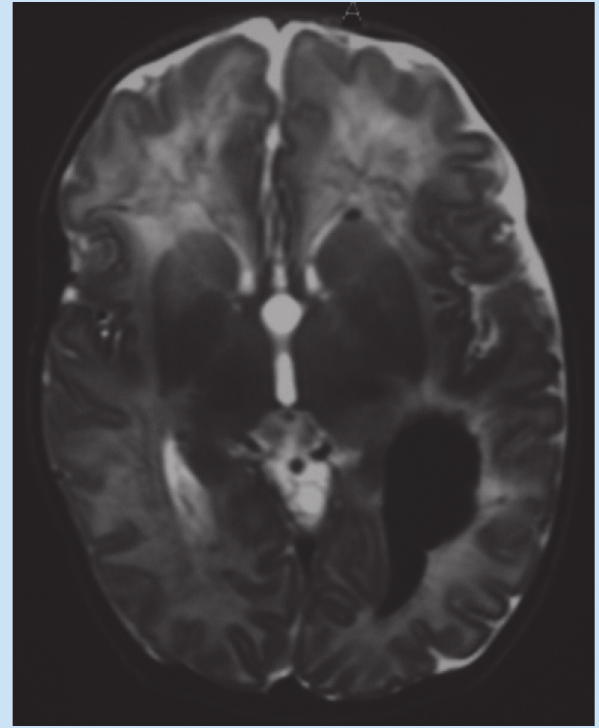
Fig. 2. The haematoma is hypointense on T2. Also note the hyperintense periventricular white matter representing hypoxic